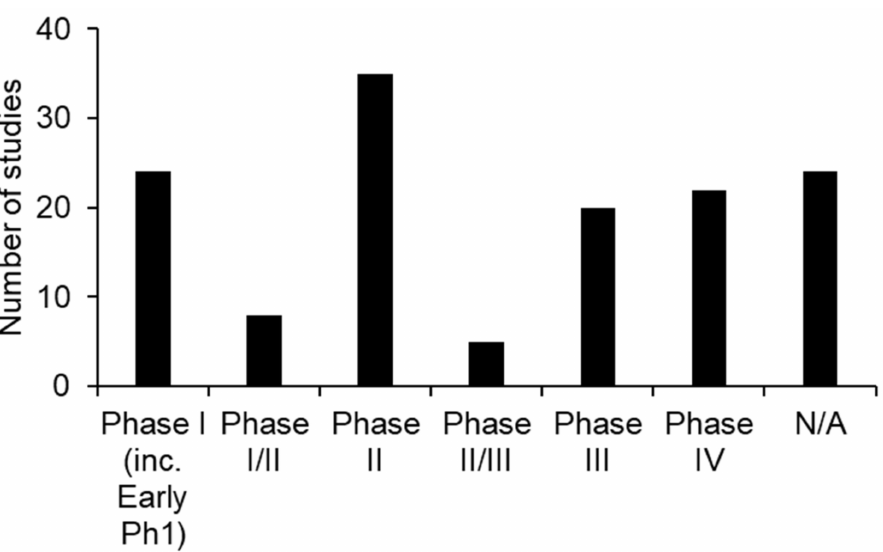
Figure 4. Completed clinical trials in TBI and their study